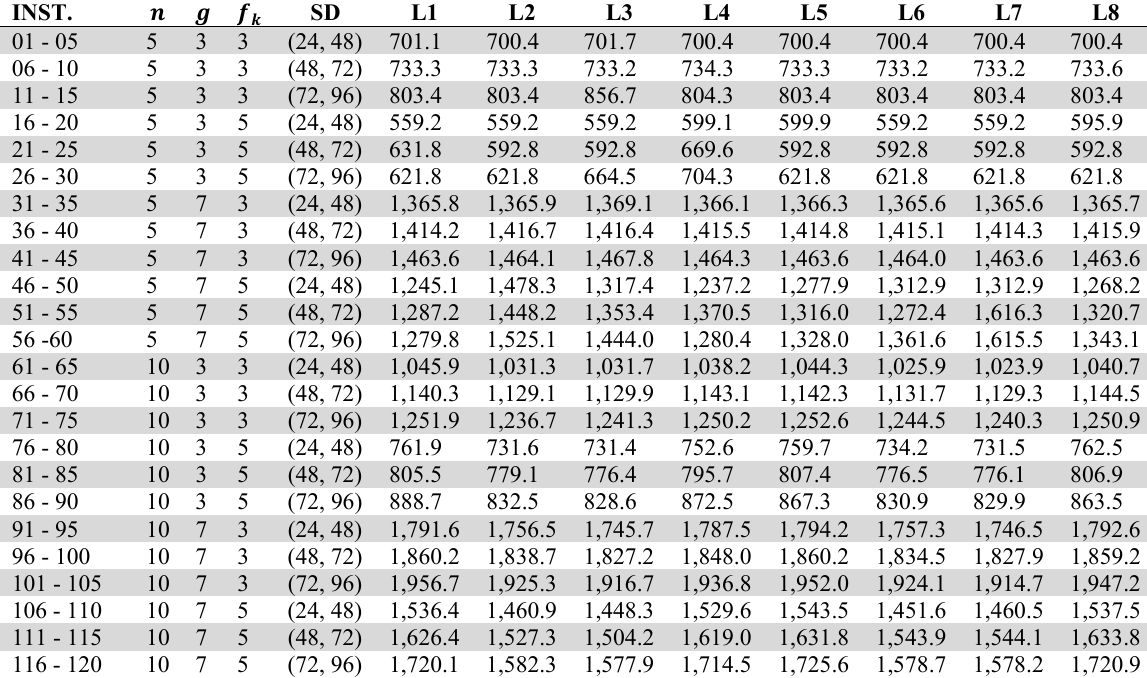
Taguchi Design - Summary of Mean Results INST.